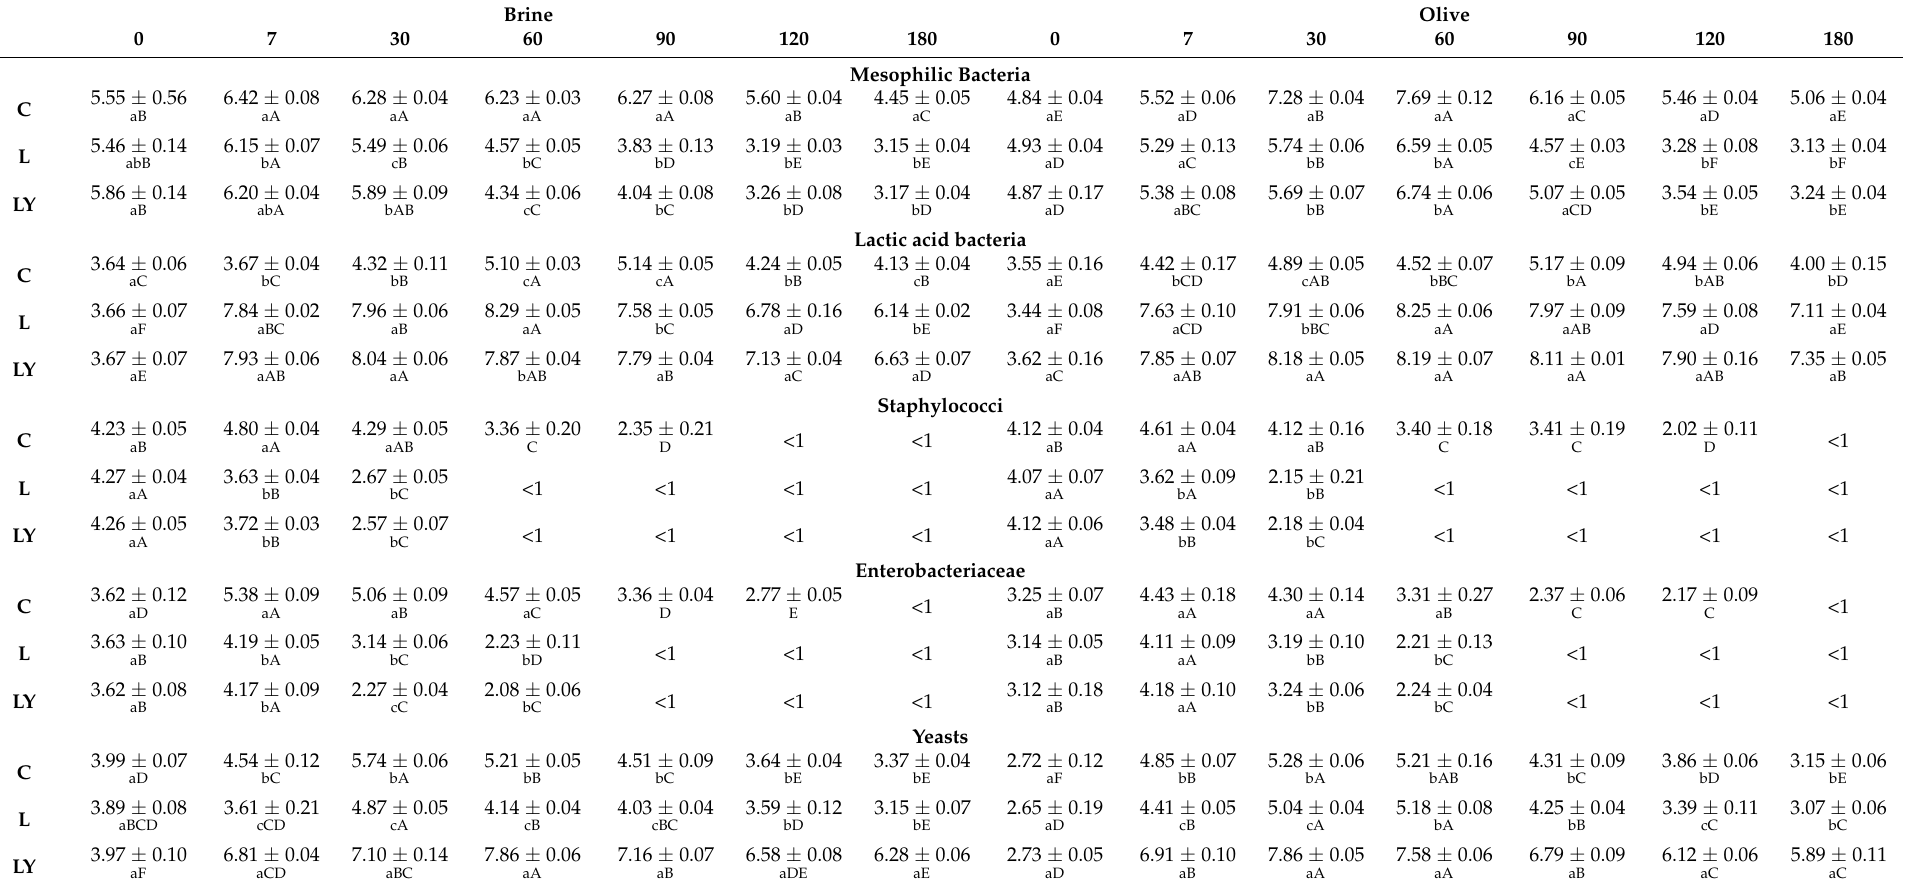
Table 2. Microbial counts detected on brine and olive samples of Nocellara Etnea cultivar v. Brine Olive